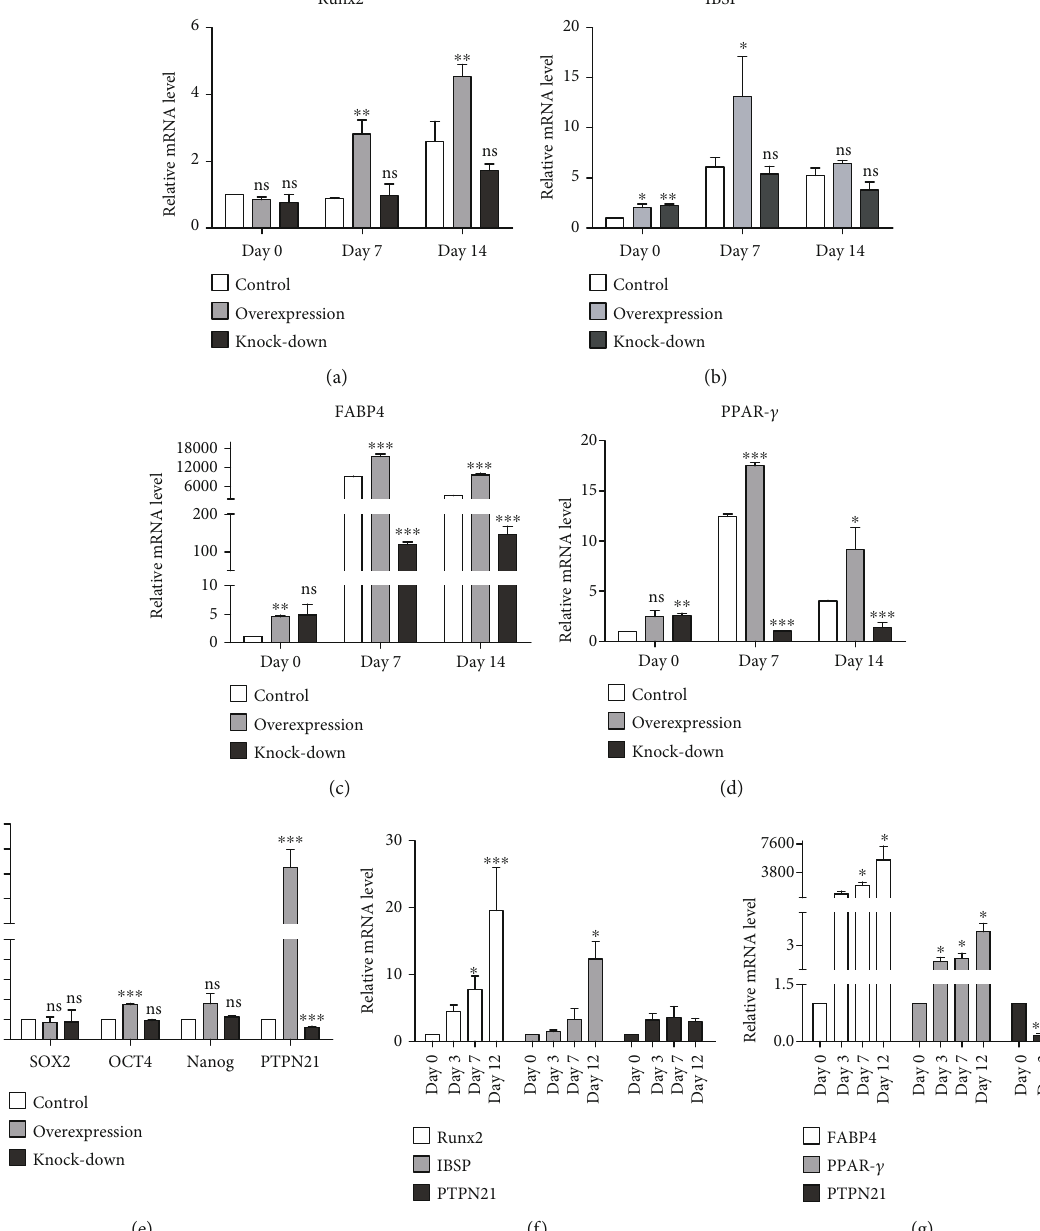
Figure 5: Statistical analysis of osteogenic and adipogenic di ff erentiation data. (a – d) Statistical analysis of mRNA expression of the osteogenic genes RUNX2 and IBSP and the adipogenic genes FABP4 and PPAR- γ on days 7 and 14 of induction in three groups of BM-MSCs. (e) The mRNA expression levels of pluripotency-associated genes Nanog , OCT4 , and SOX2 in the di ff erent groups. (f) mRNA expression of RUNX2 , IBSP , and PTPN21 during osteogenic di ff erentiation of untransfected BM-MSCs. (g) mRNA expression of PPAR- γ , FABP4 , and PTPN21 during adipogenic di ff erentiation of untransfected BM-MSCs. All experiments were repeated at least three times. Data are presented as mean ± SD . ∗ p < 0 : 05 , ∗∗ p < 0 : 01 , and ∗∗∗ p < 0 : 001 . ns: no signi fi